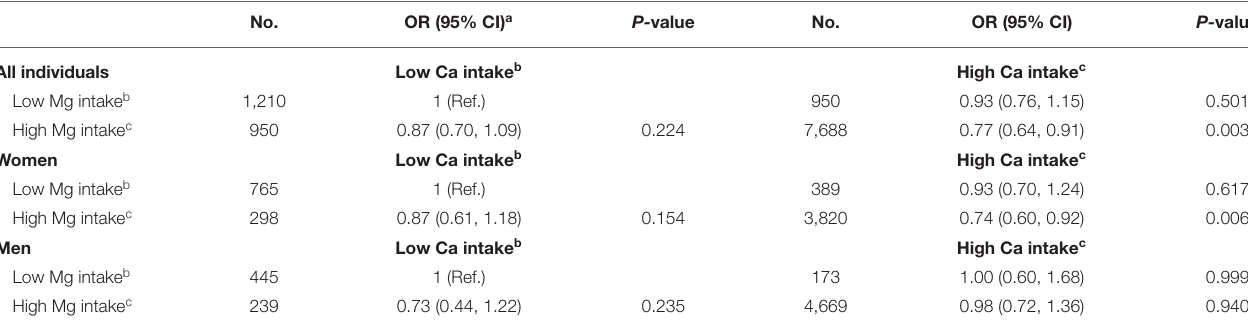
TABLE 4 | Joint association of dietary calcium and magnesium on